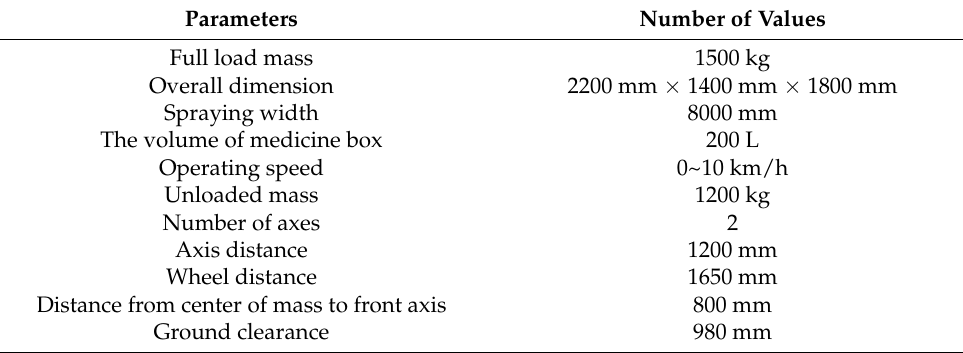
Table 2. The main parameters of